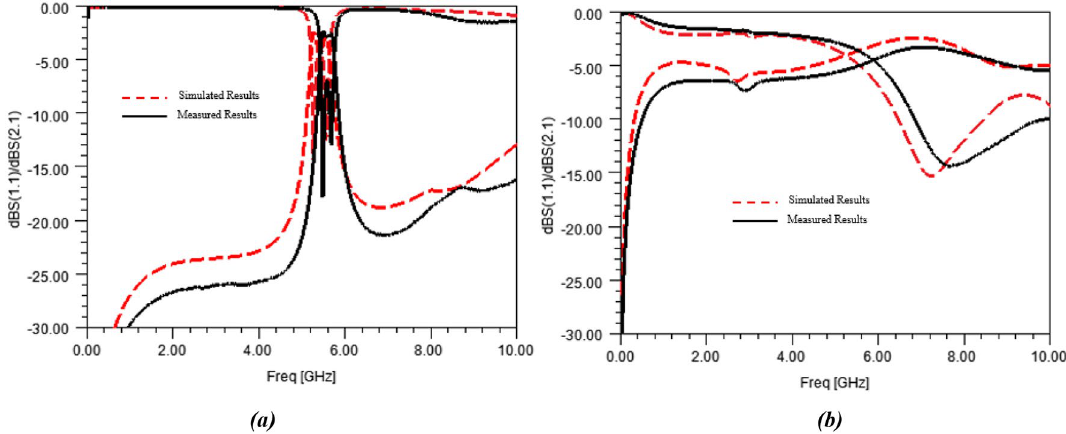
Figure 12. Simulated and measured S-parameters of the sensor with the container filled in with ( a ) air and with ( b ) DI-water.